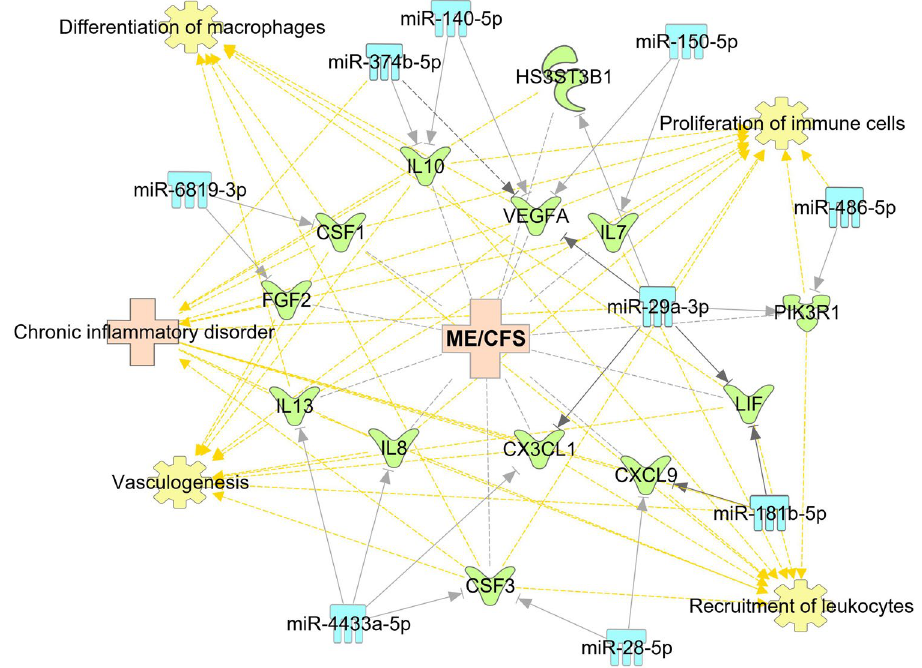
Figure 5. Genes related to ME/CFS that are predicted or confirmed targets of the 11 miRNAs. The miRNAs are presented in light blue. The targets of miRNAs are in green, ME/CFS, FM and other related diseases are in light pink, and associated functions of genes are in yellow.